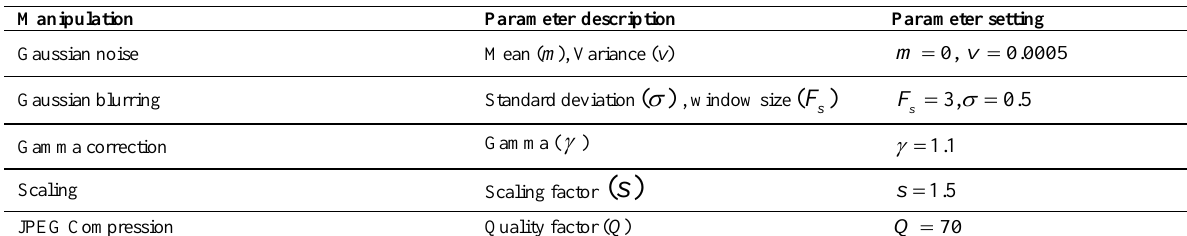
Table1. Content-preserving manipulations with some details in parameters description and setting.